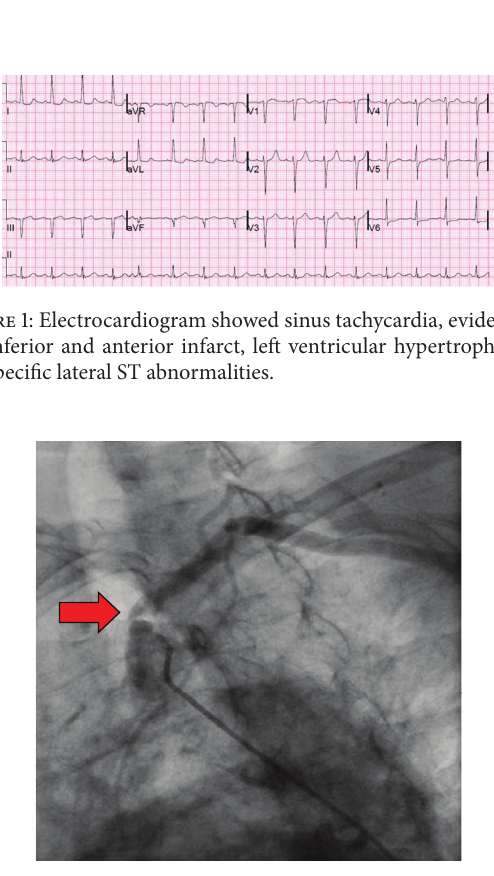
Figure2:Selectiveangiographyoftheleftsubclavianarteryrevealed 90% ostial stenosis.